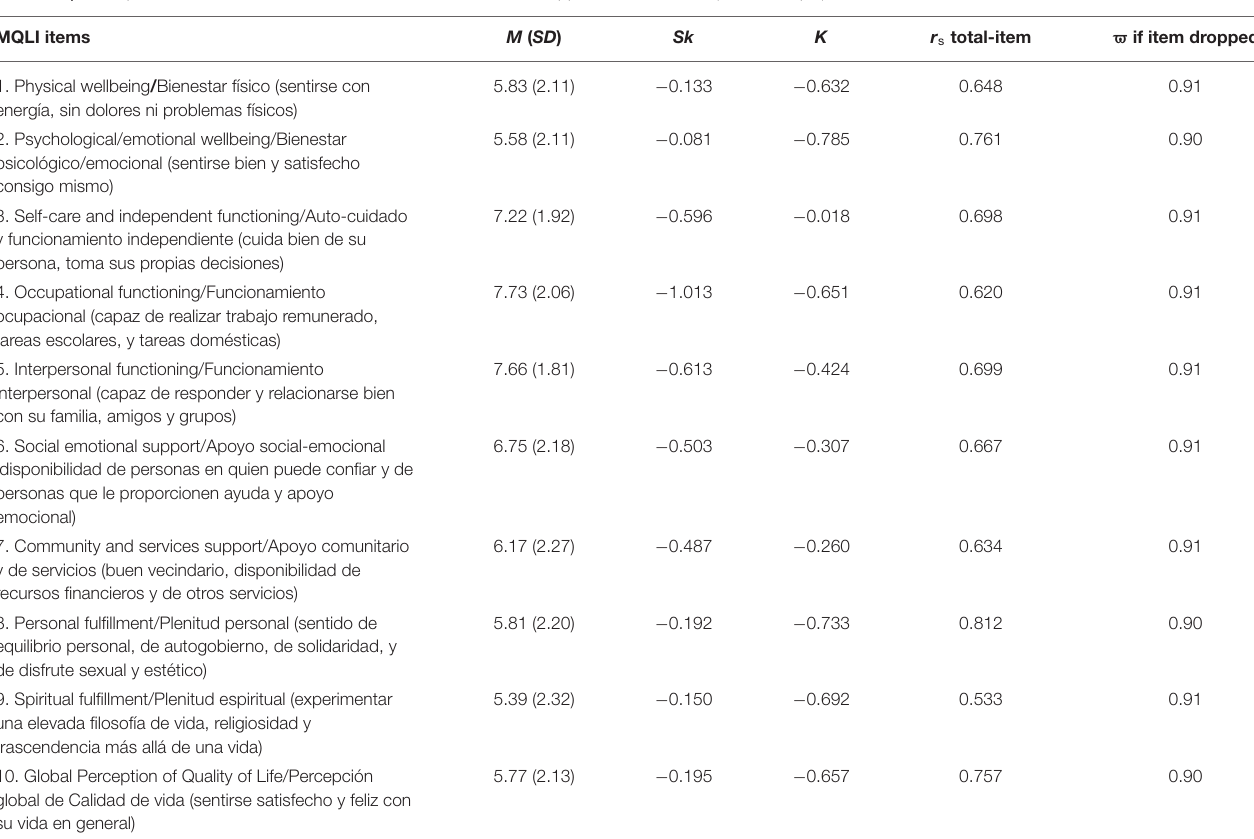
TABLE 2 | Descriptive statistics, total-item correlations, and ̟ if item is dropped from the MQLI (whole sample). MQLI